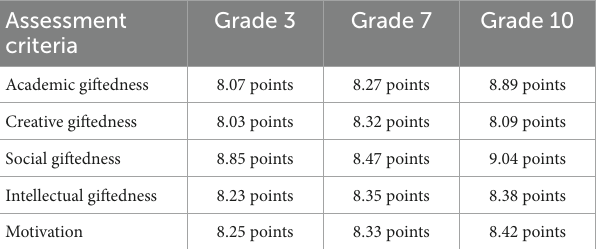
TABLE 2 Preliminary findings on student